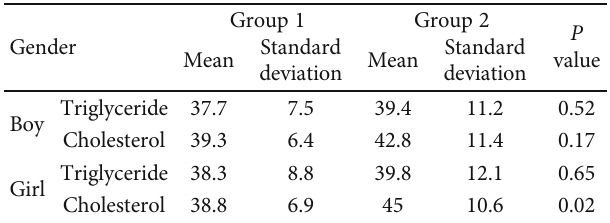
Figure 1: Serum cholesterol and triglyceride levels in both groups. Table 2: Comparison of triglyceride and cholesterol levels based on